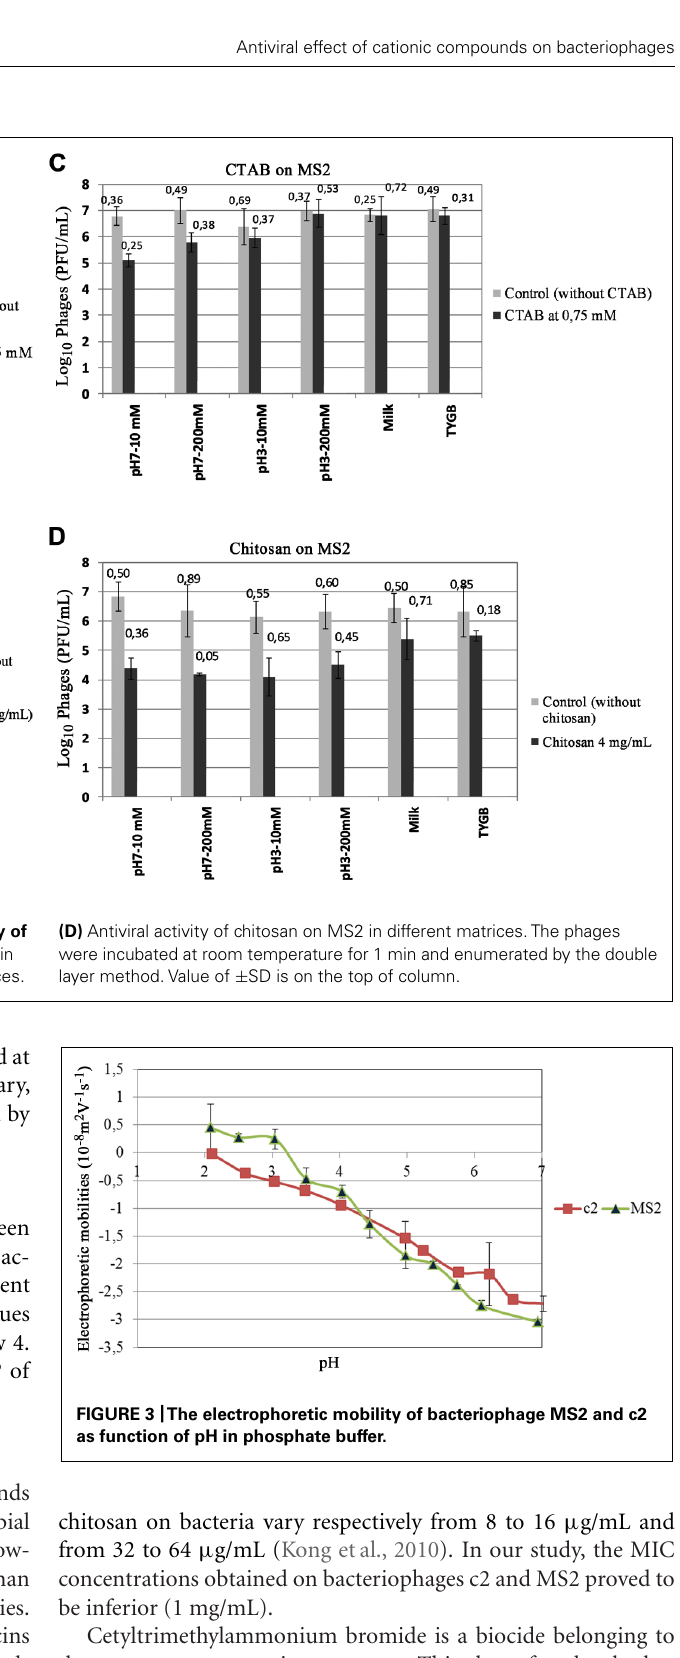
chitosan on bacteria vary respectively from 8 to 16 μ g/mL and from 32 to 64 μ g/mL (Kong et al., 2010). In our study, the MIC concentrations obtained on bacteriophages c2 and MS2 proved to be inferior (1